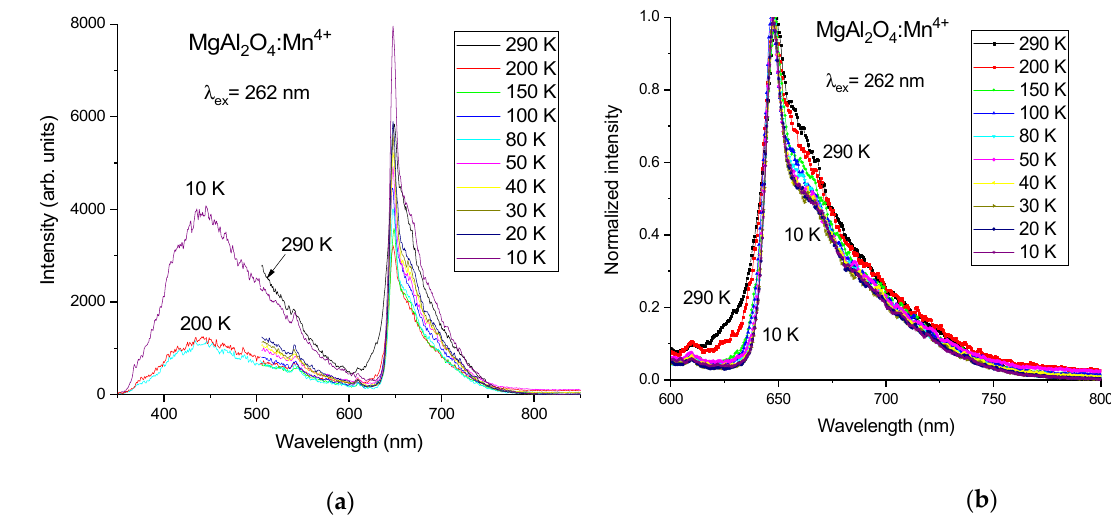
Figure 2. ( a ) PL spectra of MgAl 2 O 4 :Mn 4+ (sample I) measured at different temperatures: 290, 200, 150, 100, 80, 50, 40, 30, 20, and 10 K; ( b ) PL spectra of MgAl 2 O 4 :Mn 4+ (sample I), normalized at their peak value, for the red spectral region measured at different temperatures.